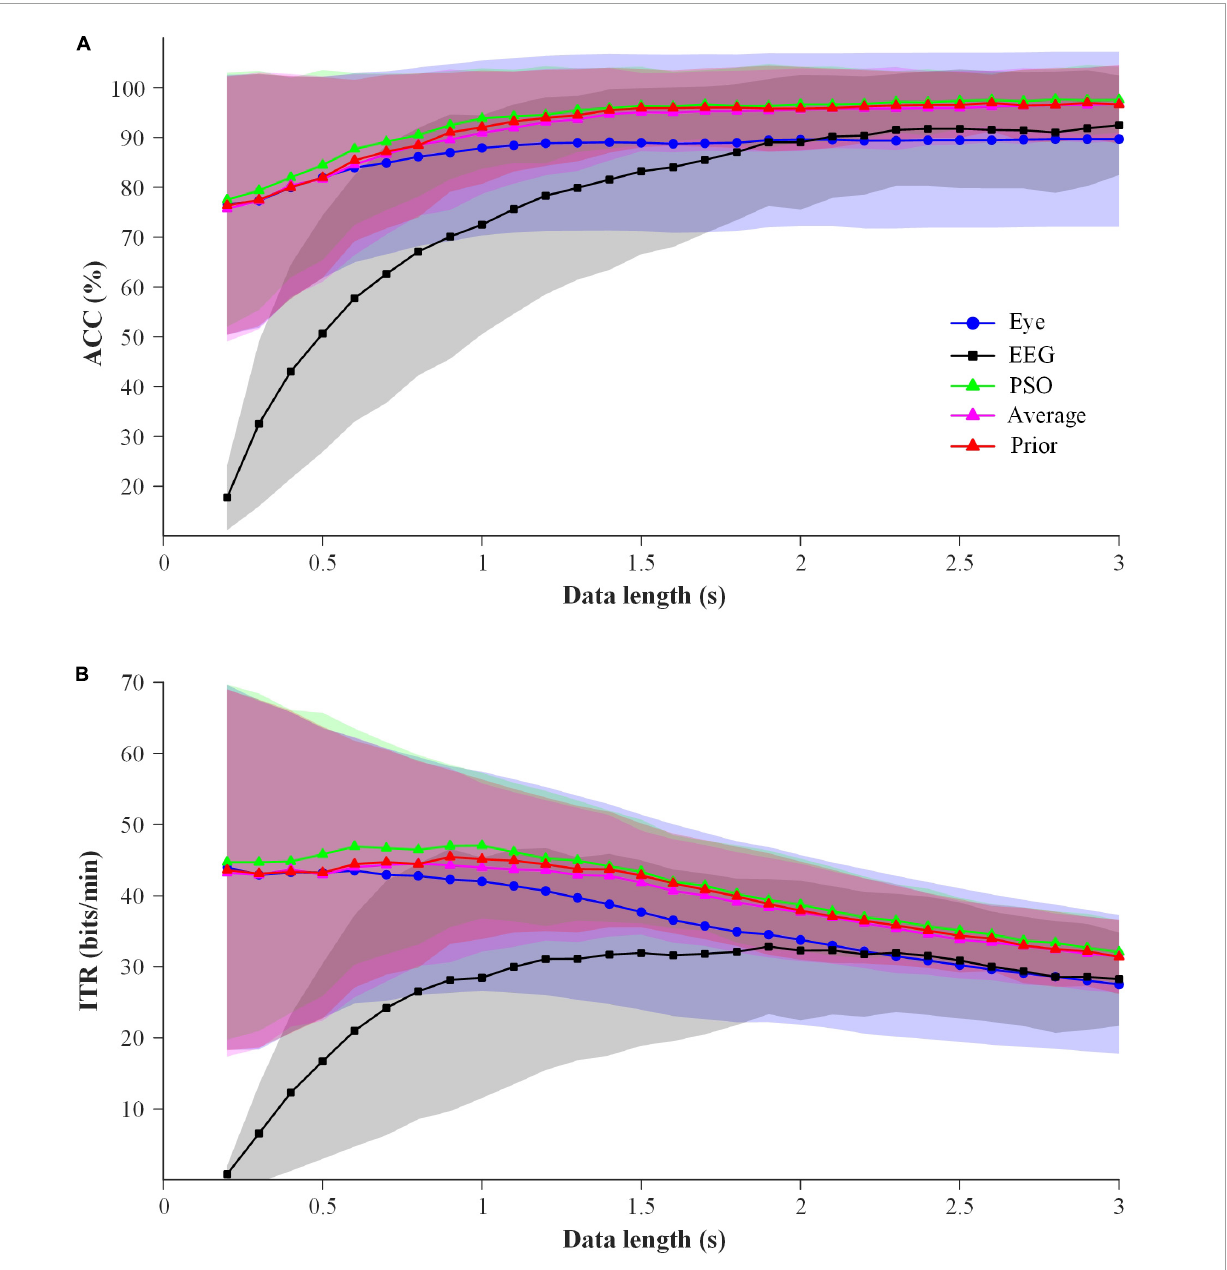
FIGURE10 The performance comparison of the EEG-eye fusion methods with 5 block data for training and 1 block data for testing at data length of 0.2–3 s for all subjects. Shaded area represents standard deviation (A) ACC. (B)